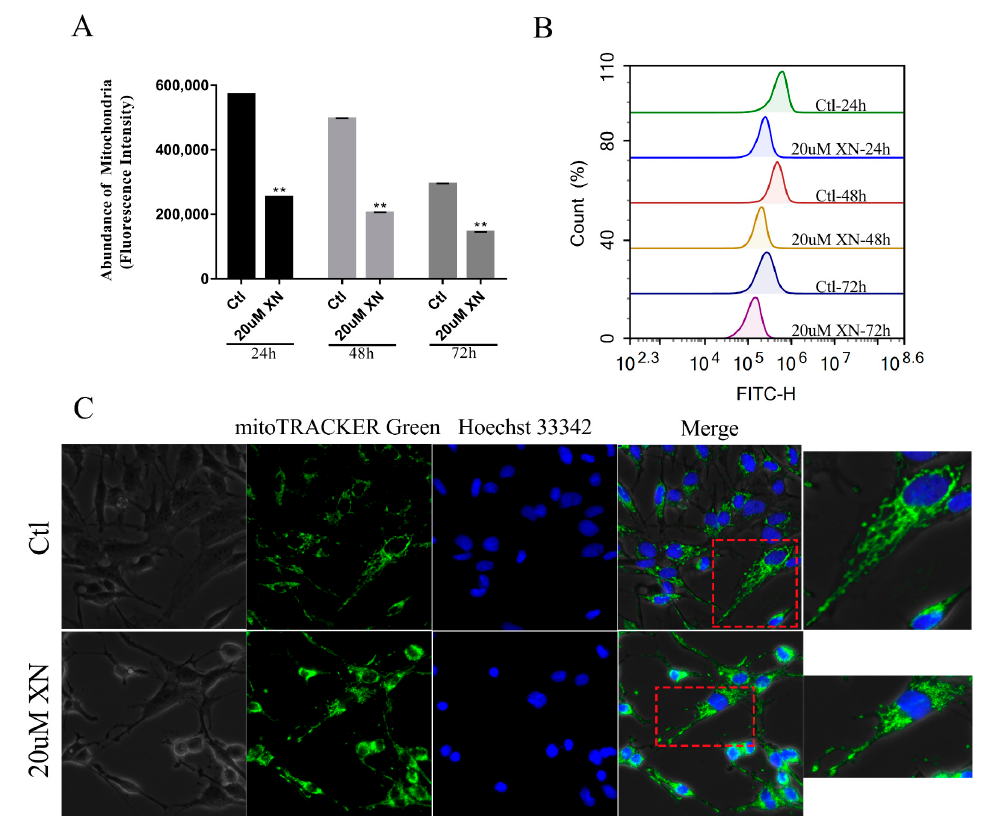
Figure 7. Effect of XN (20 uM) on mitochondrial abundance and mitochondrial morphology in C6 cells. ( A , B ) After treatment with XN for 24, 48, and 72 h, mitochondrial abundance was detected by flow cytometry after being incubated with 150 nM Mito-Tracker green for 30 min. ( C ) Cells were treated with XN for 48 h, and then visualized by a Leica Microsystems microscope after incubated with 150 nM Mito-Tracker green and 10 uM Hoechst 33342 for 30 min (400 × g magnification). All data presented are the mean ± SEM from three independent experiments. ** p < 0.01 vs. control